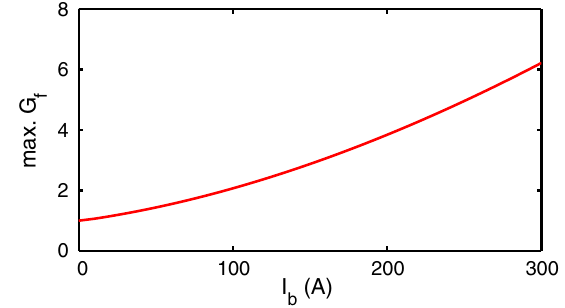
FIG. 8. Initial current dependence of the maximal microbunch- ing gains for the example arc. In the simulation we have included CSR and LSC effects.